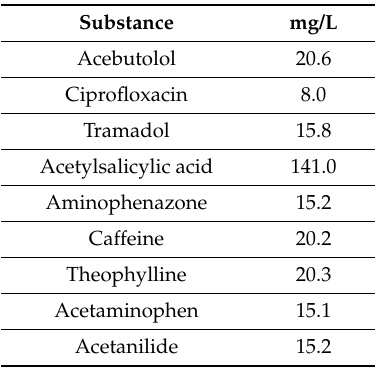
Table 2. Final concentration of substances in